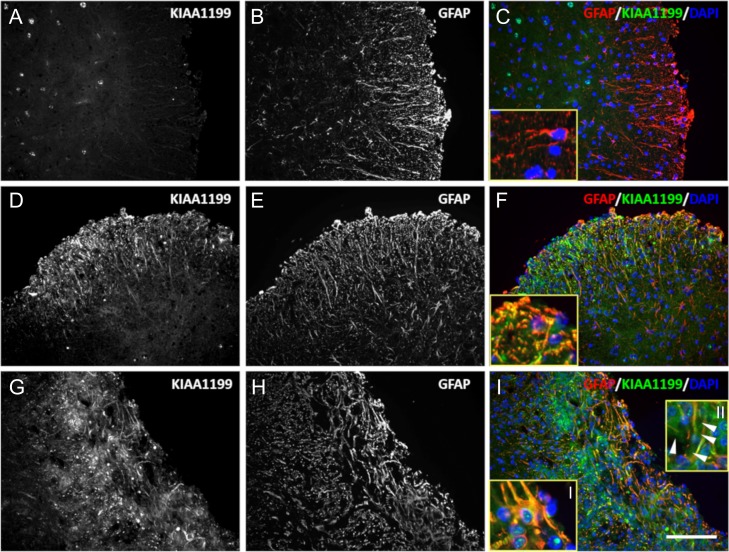
KIAA1199 protein is mainly associated with activated astrocytes. Transverse sections of the spinal cord of control (A–C) and EAE (D–I) mice were costained for KIAA1199 (A, D, G) and GFAP (B, E, H). (C), (F) and (I) are the merged micrographs that show KIAA1199 (green), GFAP (red) and the DAPI counterstain (blue); insets are high magnifications of the composite micrographs. KIAA1199 is mainly associated with the activated astrocyte processes. Additionally, in inset II of panel (I), a portion of the expressed protein does not appear to be bound to any cell structures (closed arrows) suggesting the presence of a soluble form of KIAA1199 (scale bar, 80 μm).